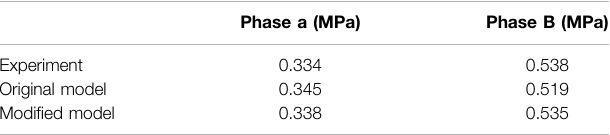
TABLE 4 | Simulation and experimental pressure comparison of MISTRA ISP47